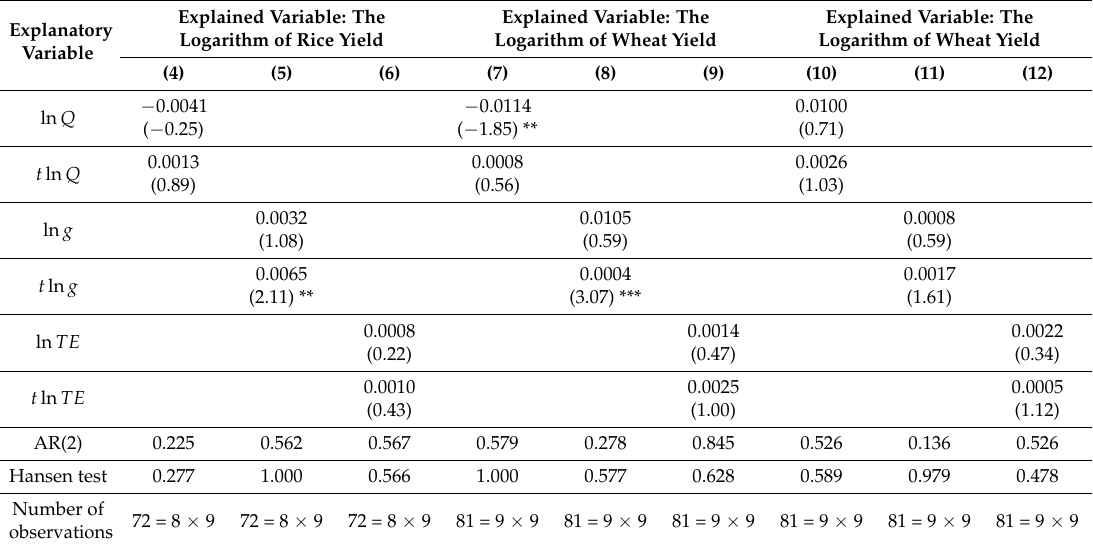
Table 2. Estimate of the grain quality influencing grain